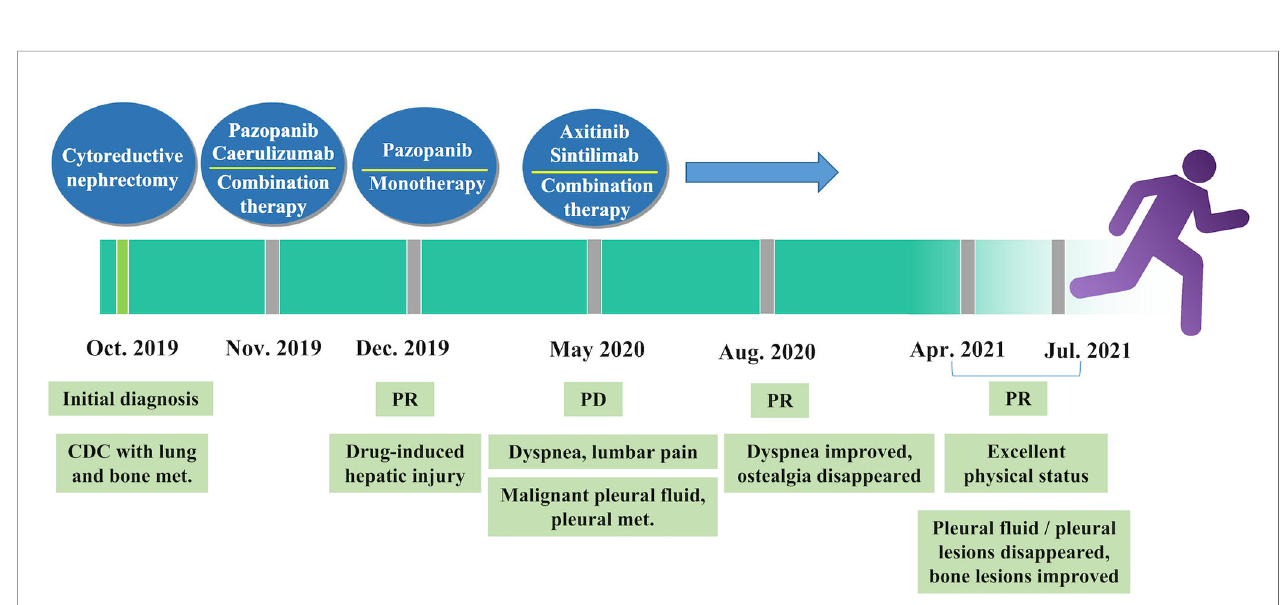
FIGURE 4 | Timeline of treatment. CDC, collecting duct carcinoma; met., metastasis; PD, progressive disease; PR, partial response.